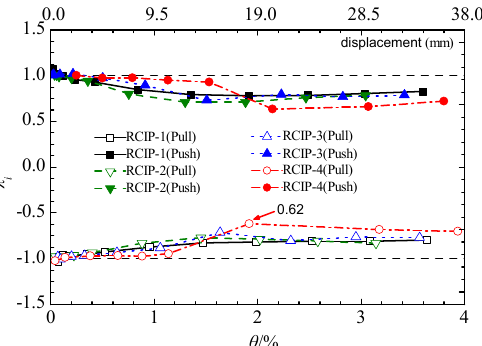
Figure 15. Lateral strength degradation curves for the tested specimens.